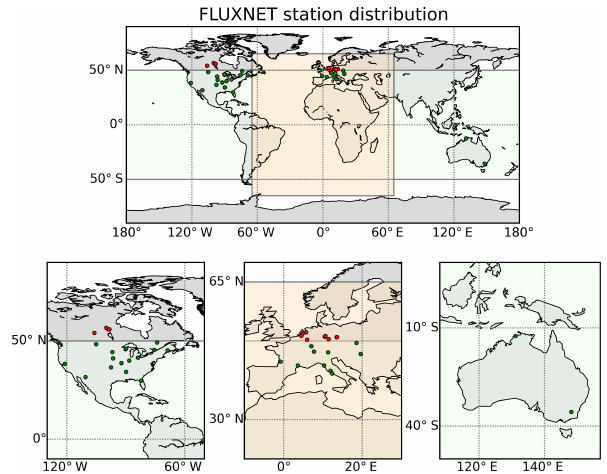
Figure 3. Distribution of FLUXNET stations used in this study. Light green corresponds to latitudes between 50 ◦ N and 50 ◦ S, which corresponds to the coverage of the TMPA precipitation data (see text). Stations in red cannot be used when forced with TMPA data. Light orange indicates approximate coverage of Meteosat